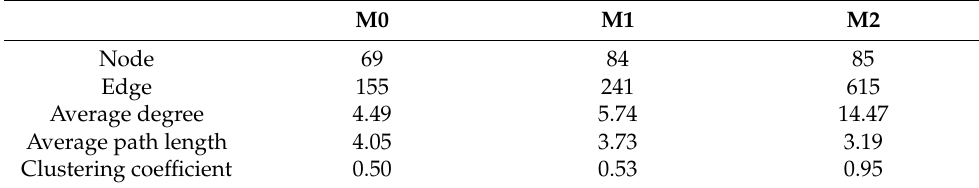
Table 3. Fungal network properties at different plantation management practices.